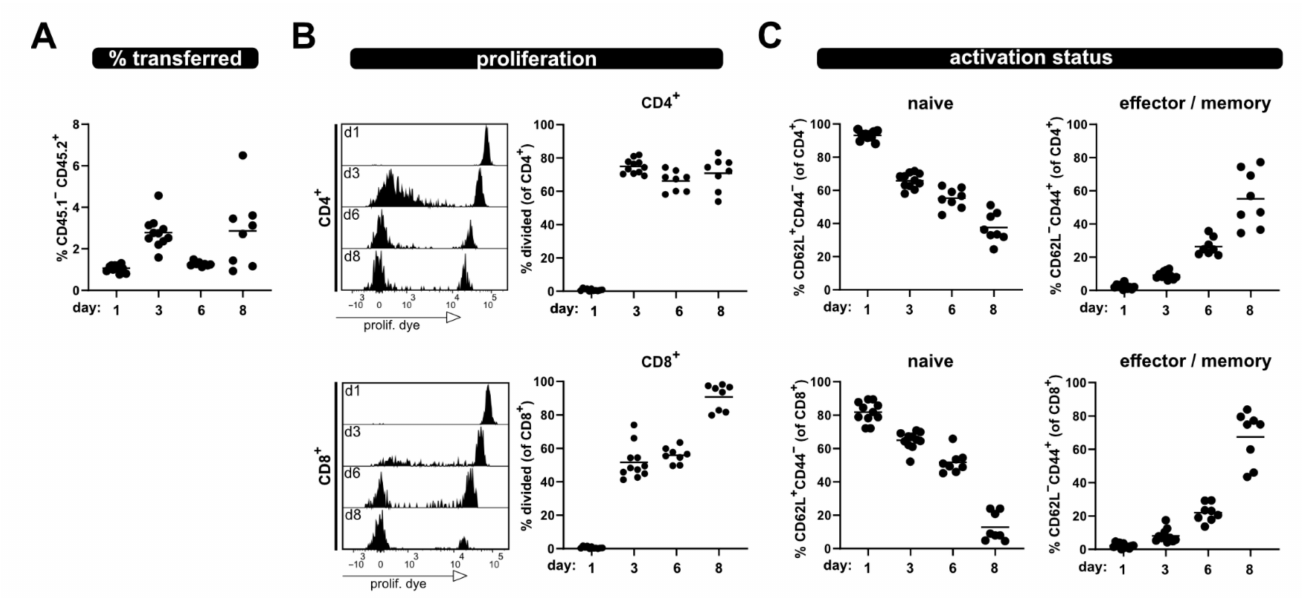
Figure 2. Kinetic of allogenic T cell activation in blood sample. Transferred T cells were analyzed from the blood at day 1, 3, 6 and 8 after transfer for ( A ) their frequency among lymphocytes, ( B ) pro- liferation of CD4 + and CD8 + T cells as well as ( C ) naive and effector/memory status—analogous to what is shown in Figure 1. Data are represented as individual values plus mean. Representative FACS histograms of individual mice are